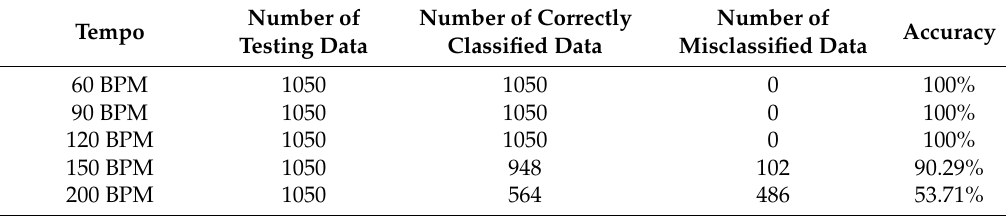
Table 4. Accuracy of musical gestures classified by BPM.